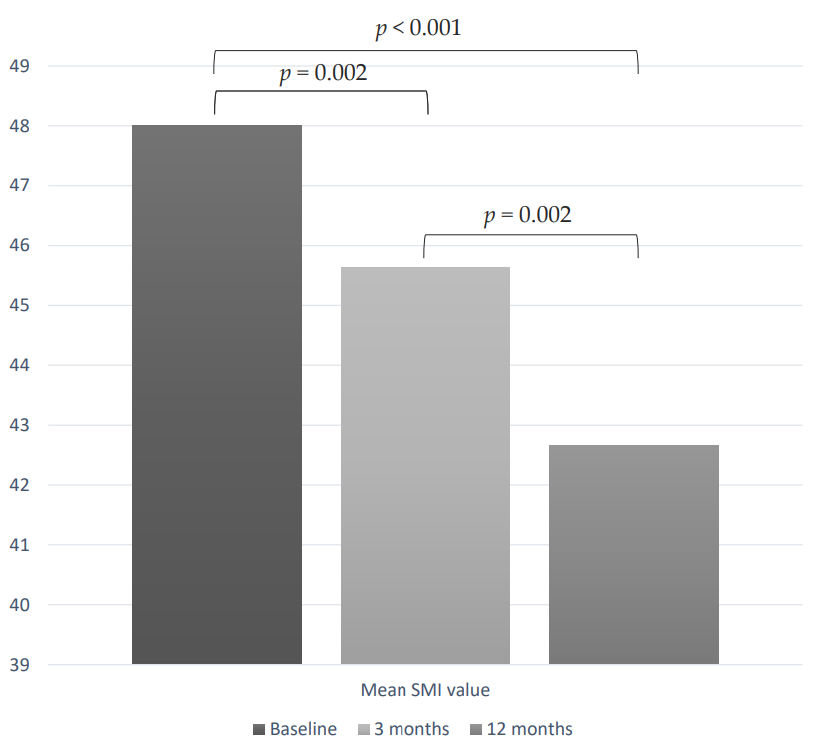
Figure 2. SMI values variations during TKI treatment in a subgroup of 39